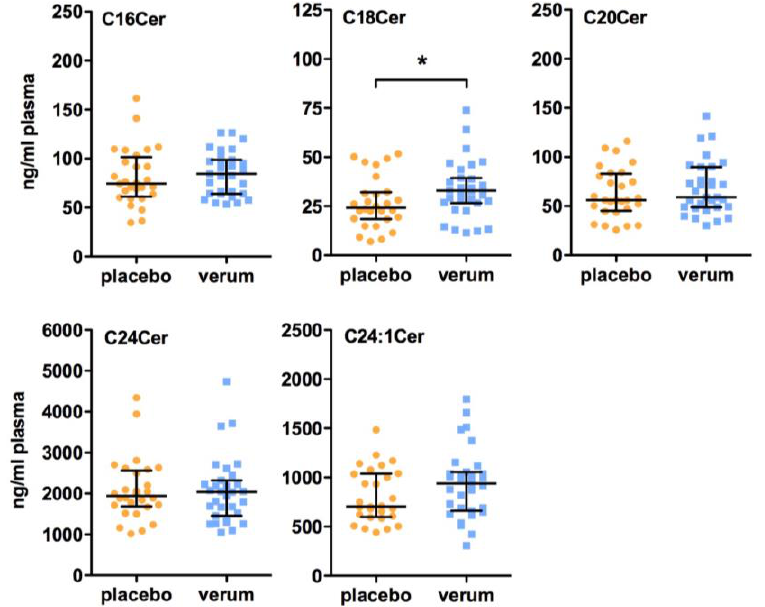
Figure 2. Effect of vitamin D supplementation on plasma ceramide (Cer) levels. All patients were treated for 6 months with either a placebo or 1904 IU/d vitamin D. Plasma sphingolipid concentrations were measured by LC-MS/MS. Dates are shown as median ± IQR (Mann Whitney U test, * p < 0.05). Abbreviations: Cer, ceramide.